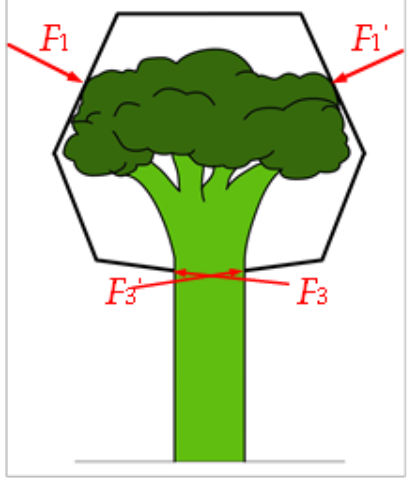
Figure 4. Clamping workspace of the manipulator.